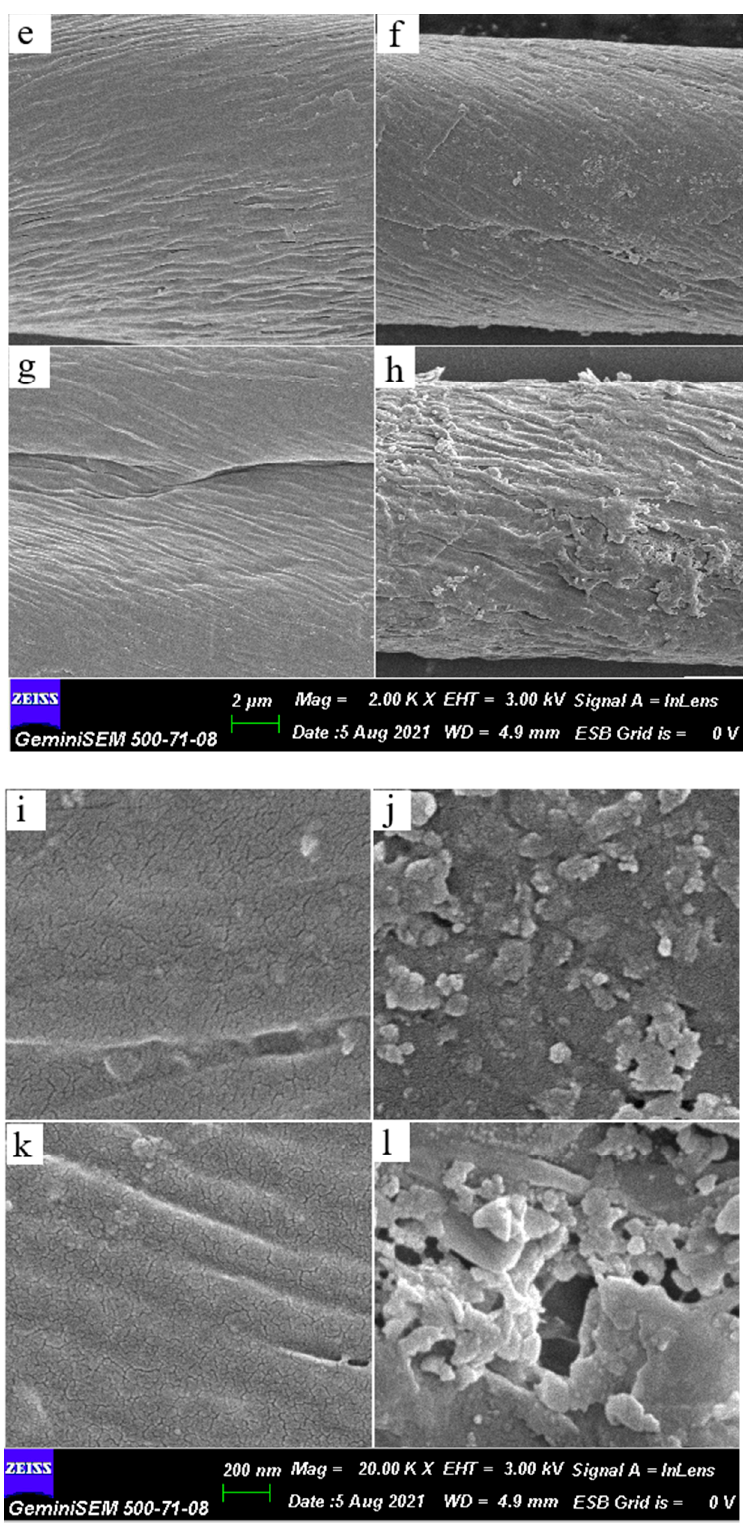
Figure 4. SEM images of cotton-OH ( a , e , i ); cotton-OH-Ag ( b , f , j ); cotton-(PO(OH)2)(Cl) ( c , g , k ); and cotton-(PO(OH)2)(Cl)-Ag ( d,h,l ). Scale bars are 1 µ m in ( a – d ), 2 µ m in ( e – h ), and 200 nm in ( i – l ). EDX spectra were recorded to confirm the presence of Ag in the samples (Figure S6). A characteristic signal for Ag was detected at 3 kV and the very low intensity of the Ag peak may be associated with a low concentration of loaded Ag-containing